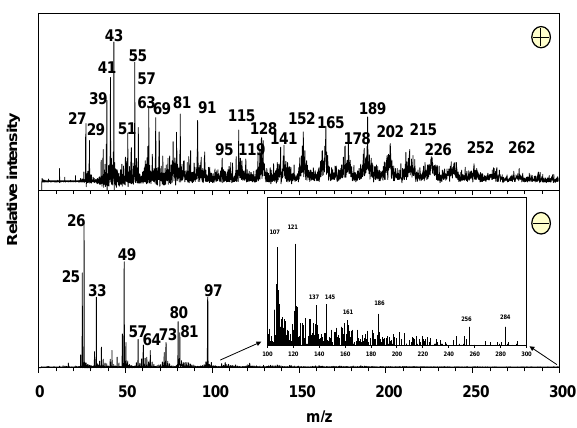
Fig. 2. Single particle positive and negative mass spectra of an in- dividual particle belonging to ART-2a cluster SOA-PAH.